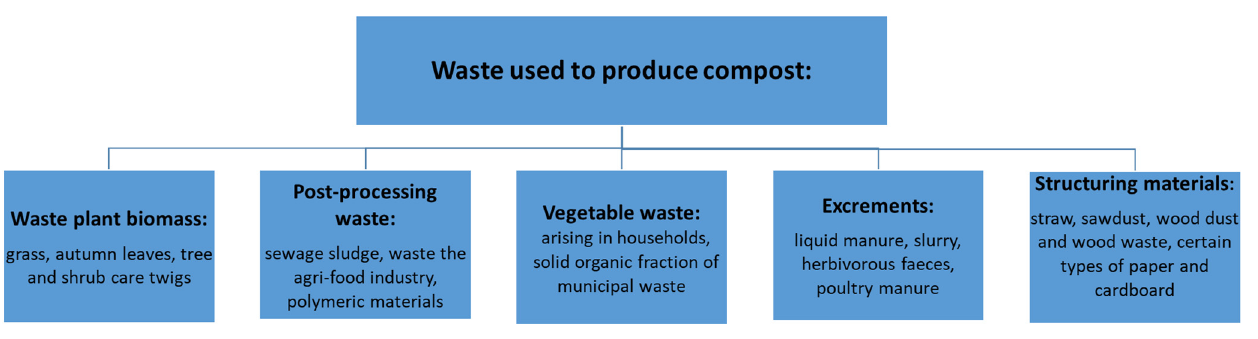
Figure 3. Materials used in the composting process [18–23].